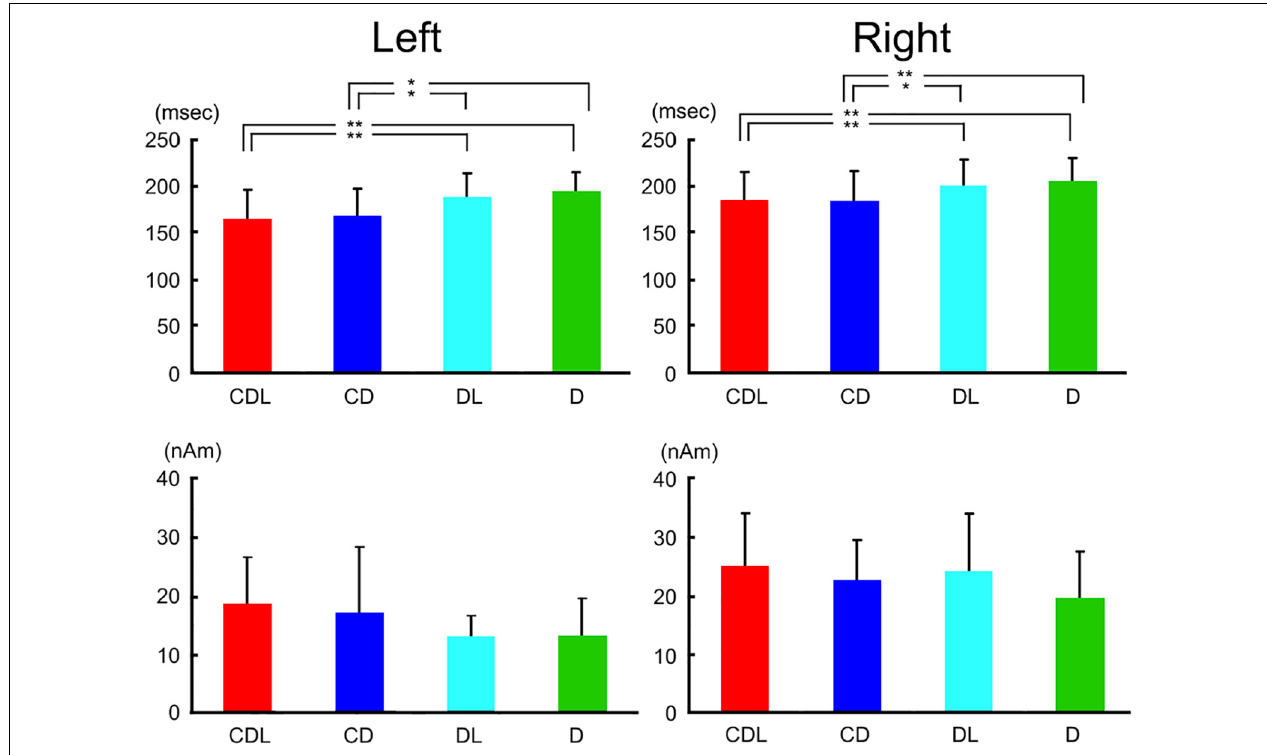
FIGURE 3 | Bar graphs of peak latency (upper) and the maximum amplitude of dipole moment (lower) for all conditions after stimulus onset in the right and left hemispheres. Error bar shows the SD [adopted from Miki et al. (2007)]. ∗ p < 0.05 and ∗∗ p < 0.01. SD, standard deviation.